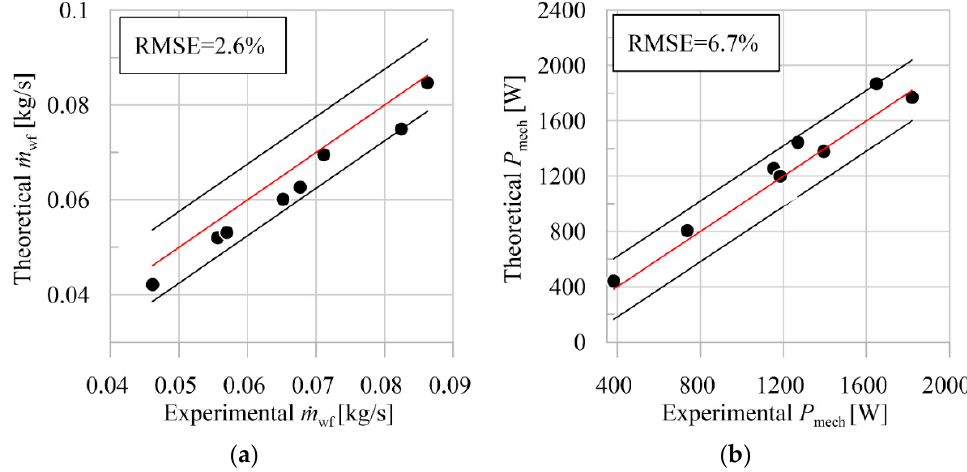
Figure 5. Comparison between experimental and theoretical mass flow rate ( a ) and mechanical power ( b ). power ( b ).